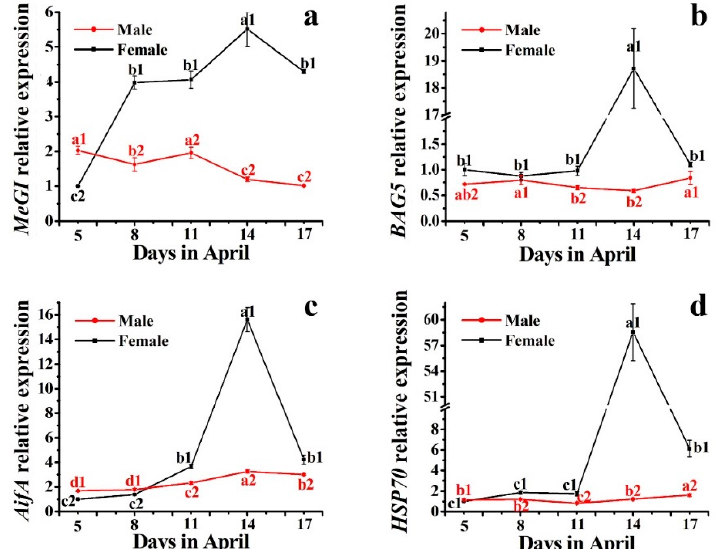
Figure 10. RT-qPCR analysis of the expression levels of PCD-related genes correlated with male floral organs during different developmental stages. ( a – d ) represent the relative expression levels of the genes homologous to MeGI , BAG5 , AifA , and HSP70 . The value on April 5, 2017 in female floral buds was set to 1.0. Data are expressed as the mean ± standard error of three replications. Red and black letters indicate a significant difference among developmental stages for male and female floral buds, respectively, based on Tukey’s multiple comparison test at the P < 0.05 significance level. Different numbers indicate a significant difference between male and female flowers at each developmental stage based on an independent T -test at the P < 0.05 significance level.